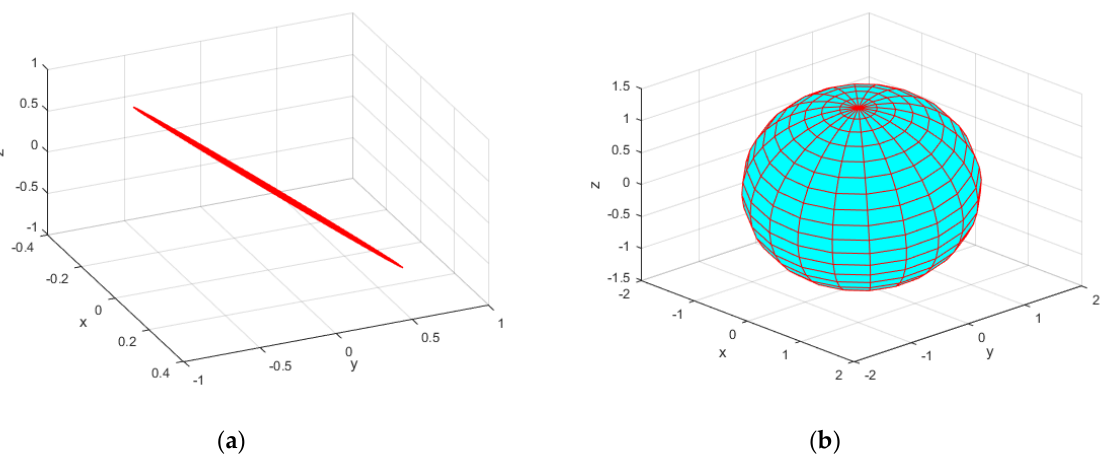
Figure 13. The EE velocity ellipsoid with d 1 = 0.3, q 2 = q 3 = q 4 = 0 ( ± π ) , and q 5 = q 6 = q 7 = π /3. ( a ) Translational velocity ellipsoid; the ellipsoid is an elliptical plate. ( b ) Rotational velocity ellipsoid.